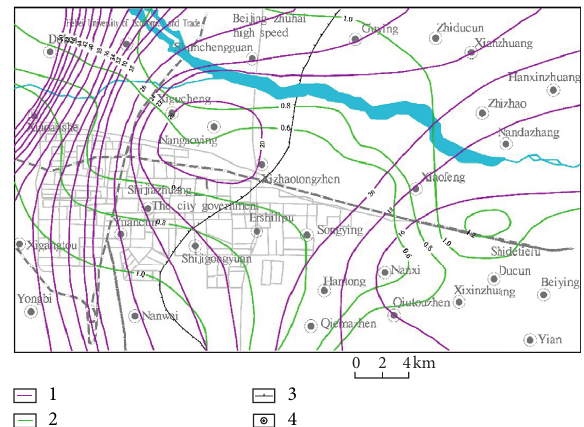
Figure 11: Contours and strontium distribution of the deep groundwater level: (1) contour lines of strontium content in deep water; (2) contour lines of water table in deep water; (3) boundary of the drainage area; and (4)